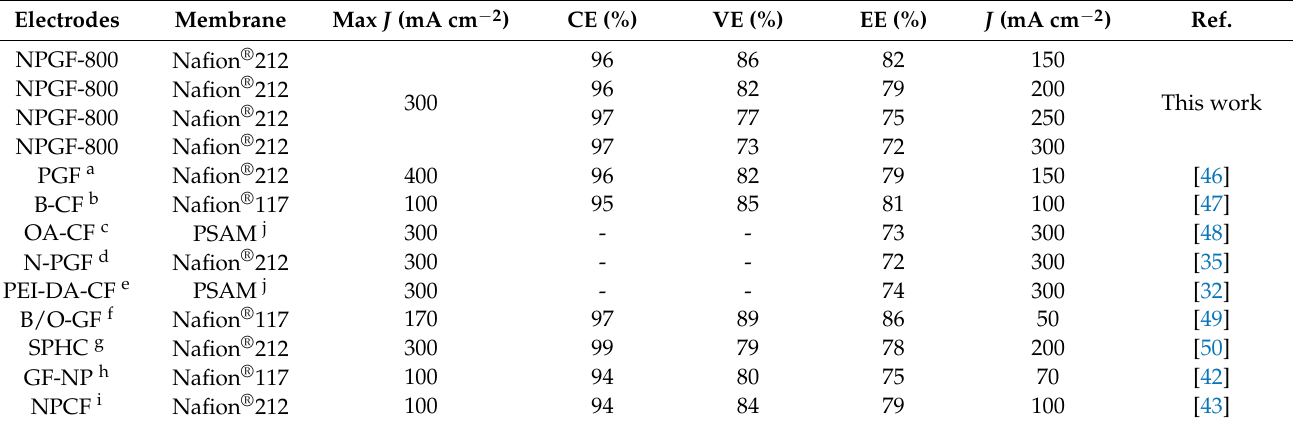
Table 2. Parameters and output performance of VRFB reported in recent